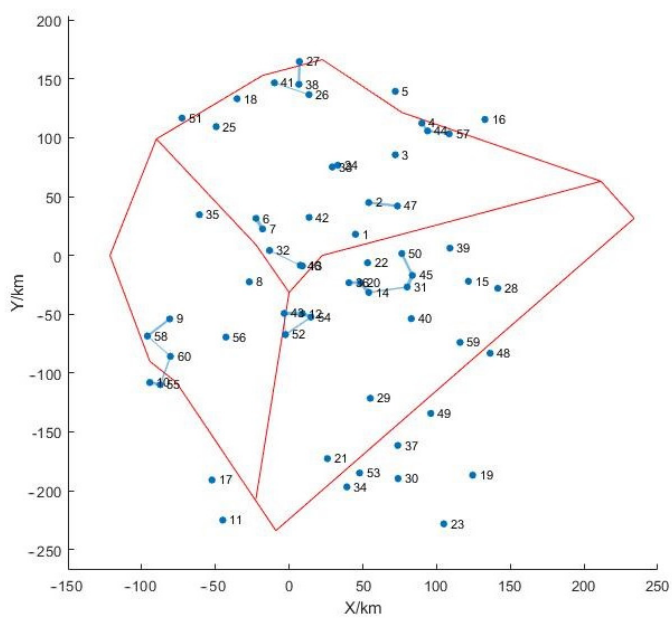
Figure 13. Flight conflict network diagram at time 1.